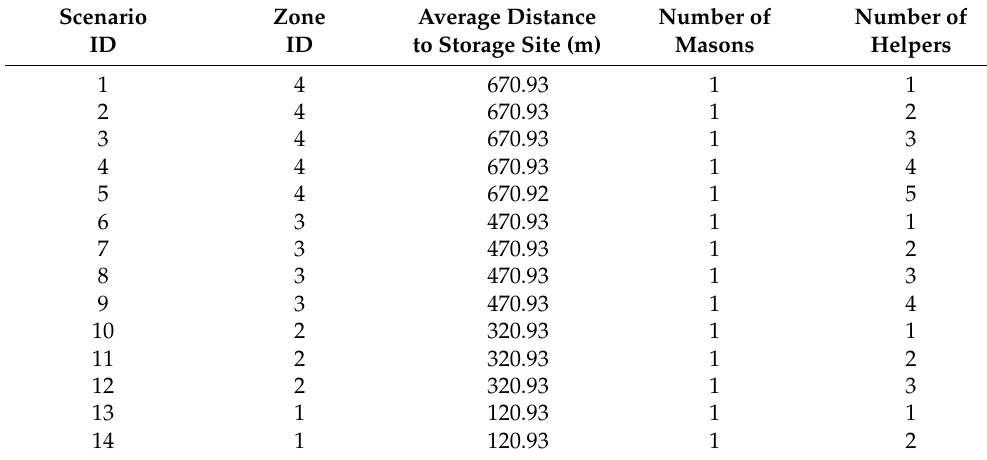
Table 5. Modelled